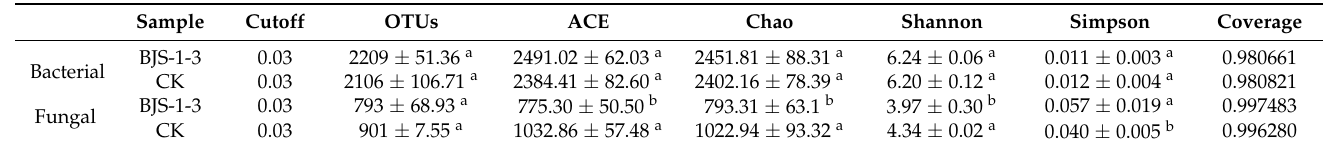
Table 4. Diversity along with richness indices of bacterial, as well as fungal communities from the two soil